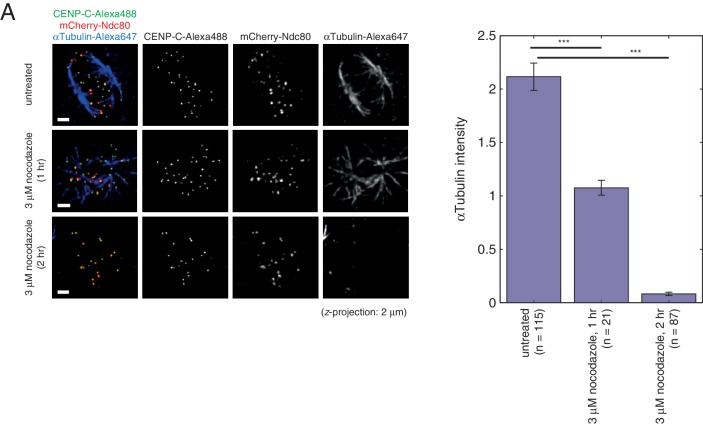
Quantification of spindle depolymerisation following nocodazole treatment.(A) Images of HeLa-K cells expressing mCherry-Ndc80 after paraformaldehyde fixation and staining of CENP-C with AlexaFluor-488 and αTubulin with AlexaFluor-647, in untreated cells and cells treated with 3 µM nocodazole for 1 hr or 2 hr (top to bottom, respectively). Each is a projection in z of 2 µm. Scale bars 2 µm. (B) Quantification of αTubulin intensity in untreated (n = 115), 1 hr nocodazole (n = 21) and 2 hr nocodazole (n = 87) treated cells (left to right, respectively), demonstrating the requirement for 2 hr incubation with nocodazole to ensure loss of the mitotic spindle. Horizontal black lines represent statistical tests between samples, where *** indicates significance with at least 99.95% confidence.